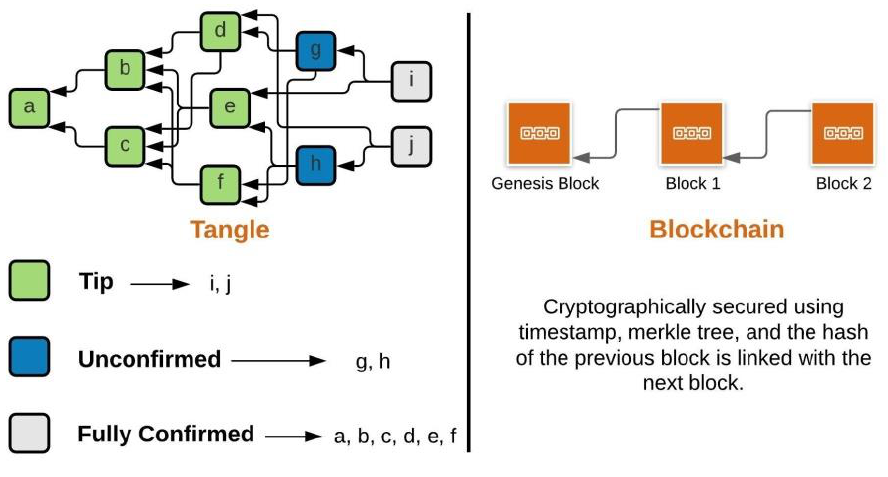
Figure 2. IOTA ‘Tangle’ versus Blockc hain.